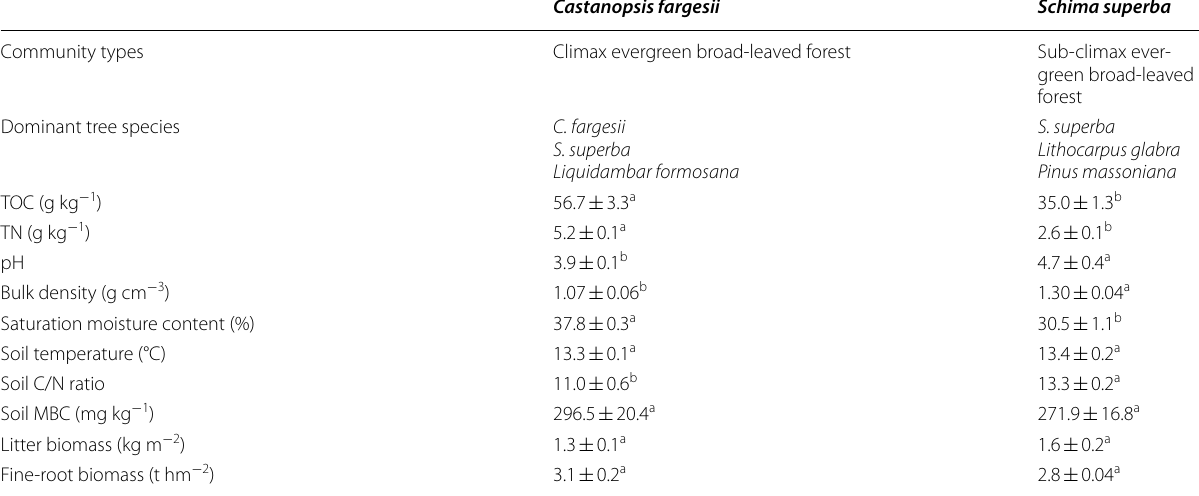
Different letters for each property indicate significant differences between these two stands ( P TOC total organic carbon, TN total nitrogen, C carbon, N nitrogen, MBC microbial biomass